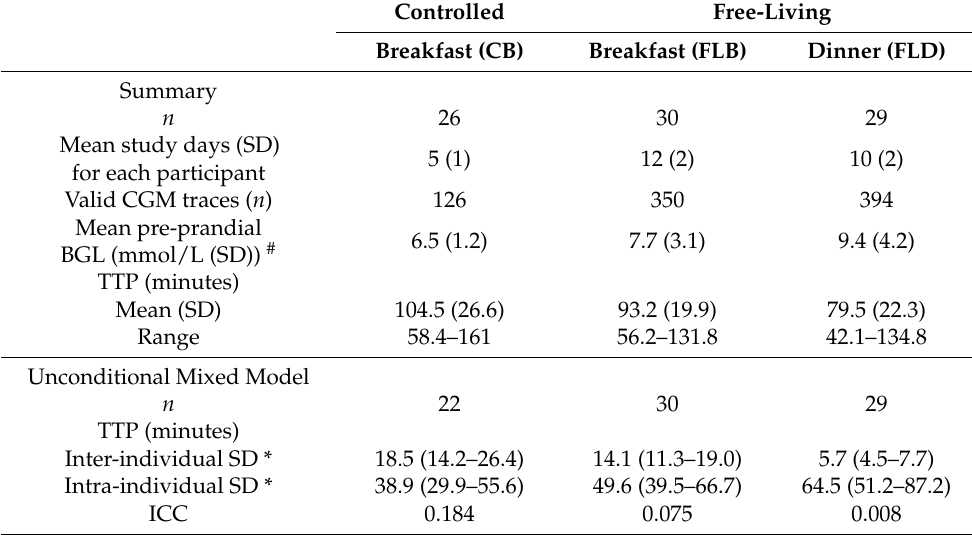
Table 3. Descriptive statistics of the TTP in each condition and mixed model output depicting the inter- and intra-individual variance components and Intra Class Correlation Coefficient